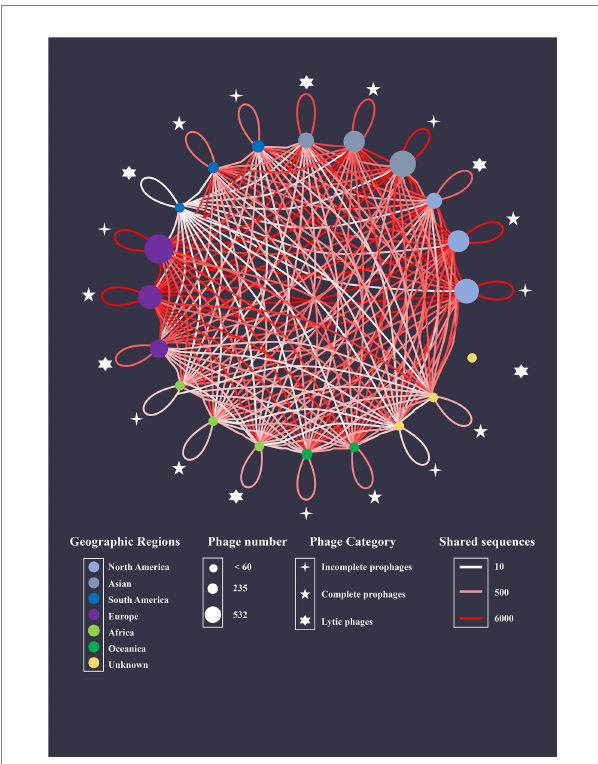
FIGURE 8 Genetic relationship network with shared sequences as coupling links. S. aureus intact prophage, incomplete prophages, and lytic phages isolated from different geographic regions are represented as nodes. The area of each node directly correlates with the average number of shared sequences connected to a species. The number of shared sequences between nodes is represented by colored